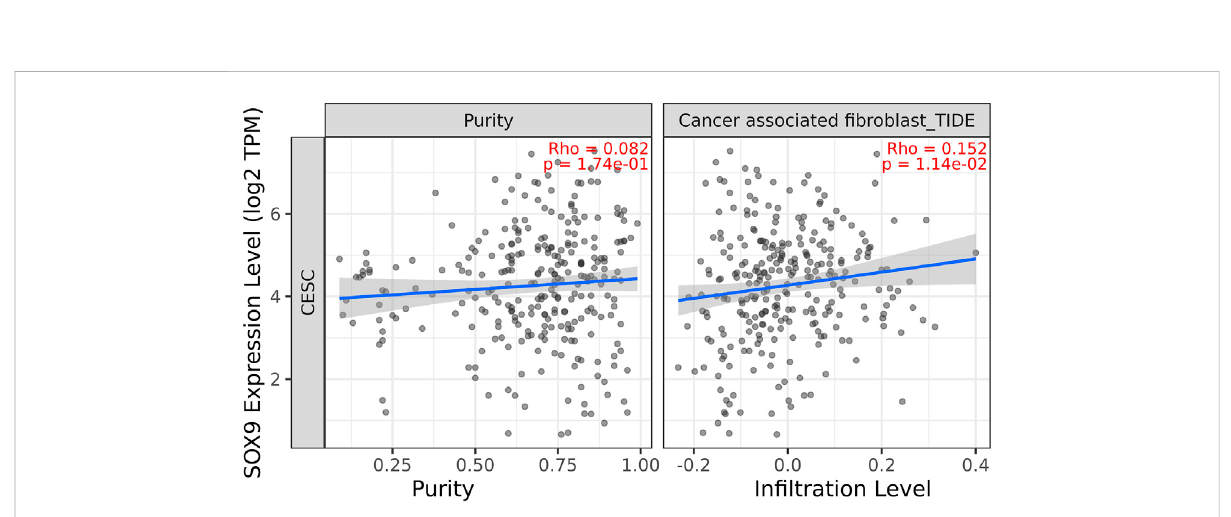
FIGURE 8 Correlation between SOX9 gene expression and CAF immune in fi ltration. Expression of SOX9 positively correlates with tumor-associated fi